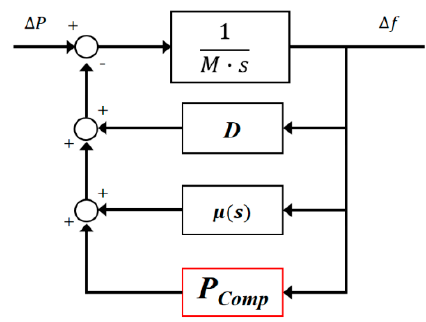
Figure 18. Block diagram of power system with compensator.